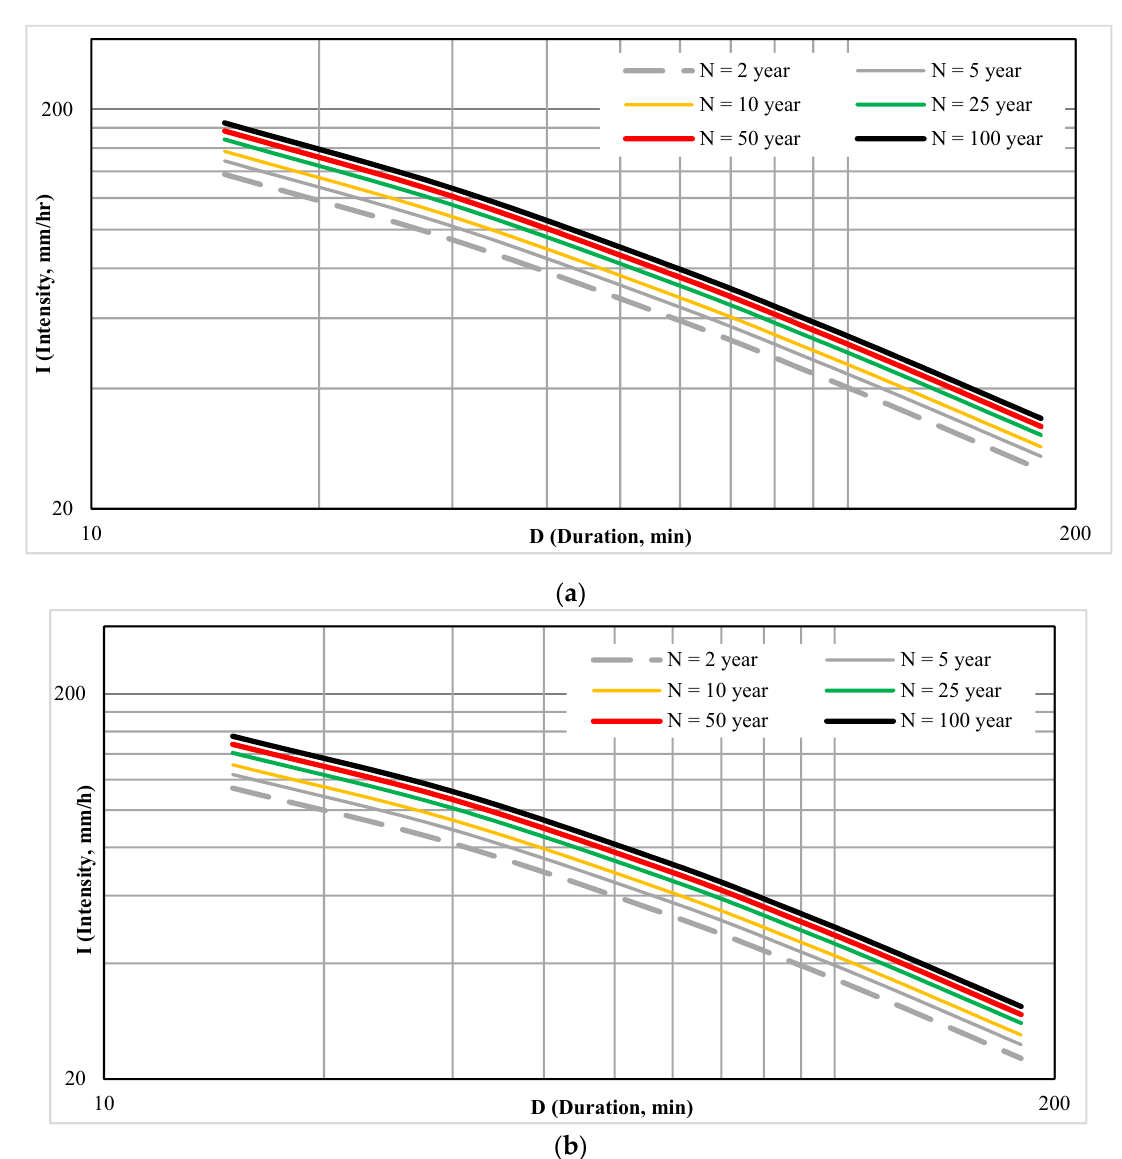
Figure 8. The IDF rainfall curve was built by the Department of Hydrology ( a ) and the Ministry of Transport ( b ).